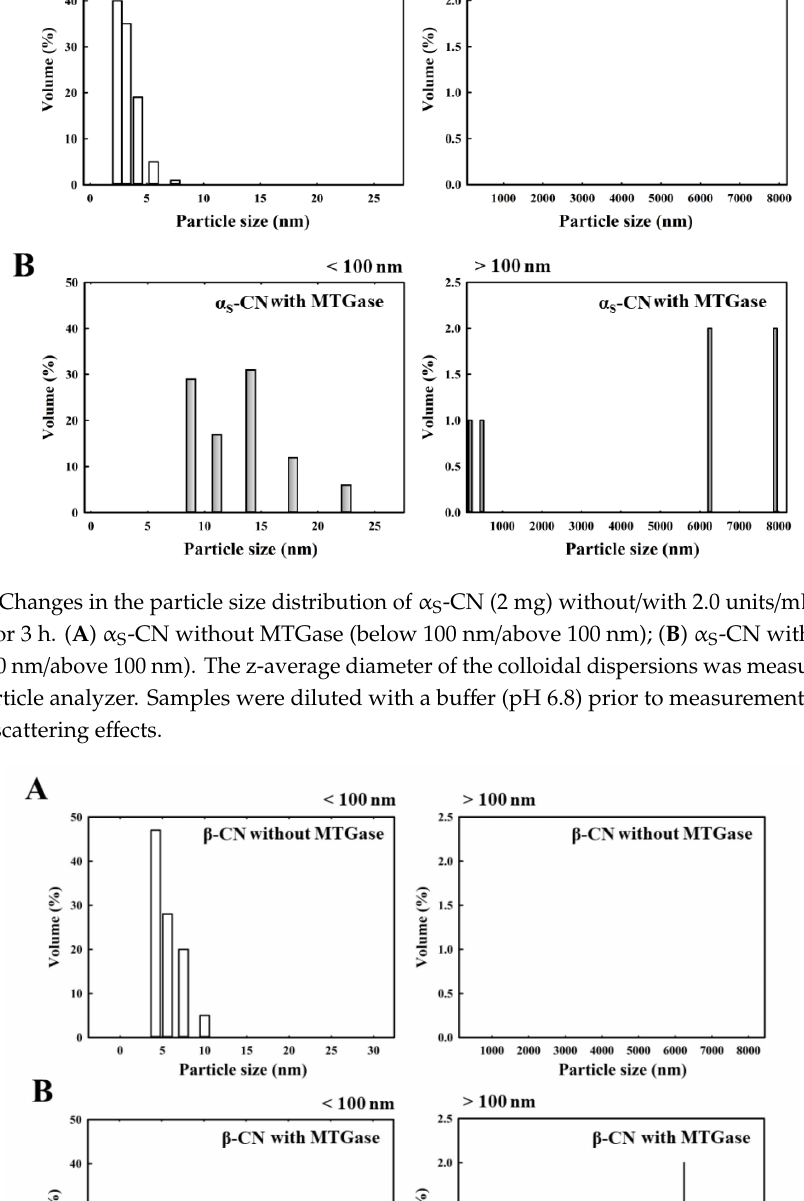
Figure 4. Changes in the particle size distribution of κ -CN (2 mg) without/with 2.0 units/mL MTGase at 30°C for 3 h. ( A ) κ -CN without MTGase (below 100 nm/above 100 nm); ( B ) κ -CN with MTGase (below 100 nm/above 100 nm). The z-average diameter of the colloidal dispersions was measured using a nanoparticle analyzer. Samples were diluted with a buffer (pH 6.8) prior to measurements to avoid multiple scattering effects.